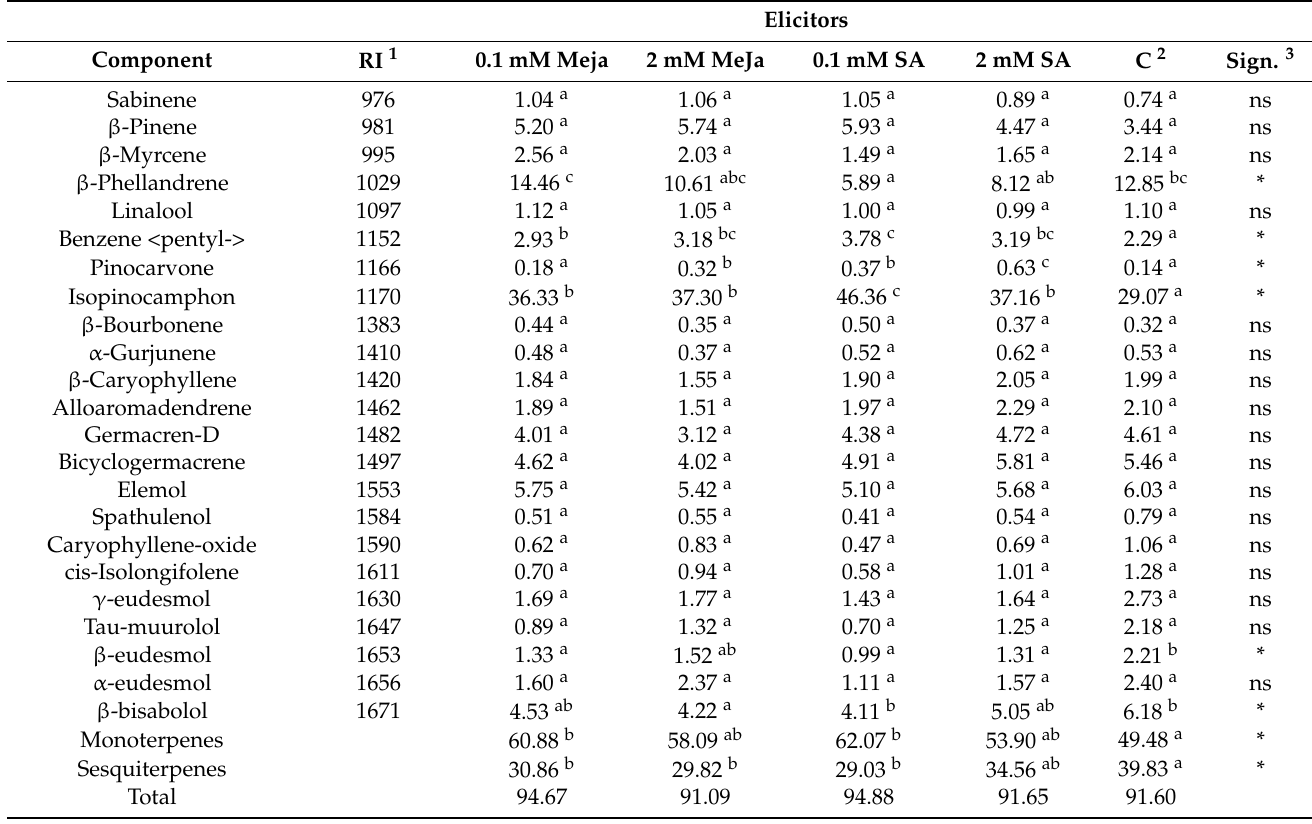
Table 6. The chemical composition of the EO of hyssop.